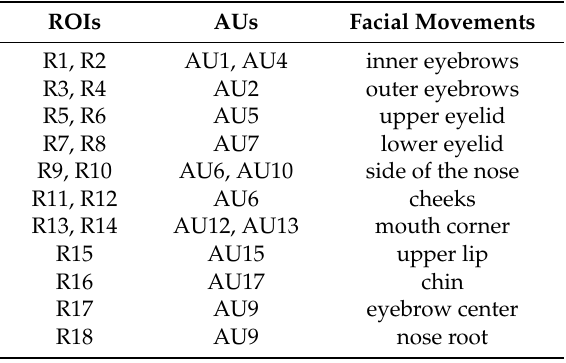
Table 1. Relationships between AUs and facial movements.